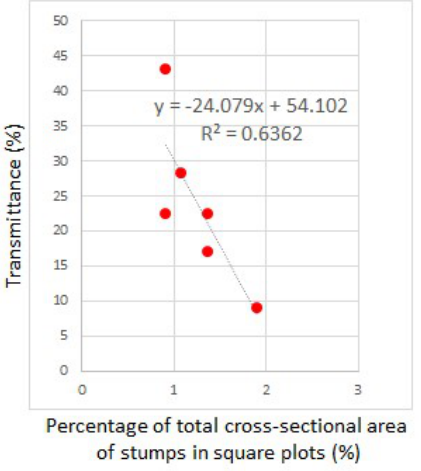
Figure 18 . Relationship between LiDAR transmittance and total cross-sectional area in granite site (Onigajo and Ojiroi) without two outlier